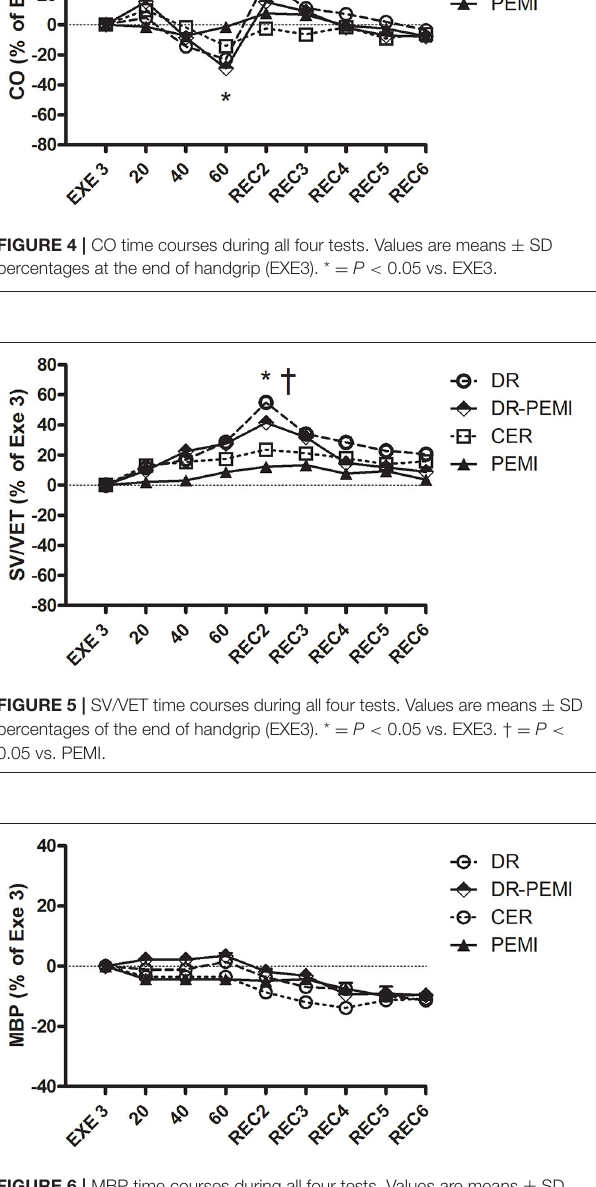
compared with Exe3, and it was significantly higher in DR than in